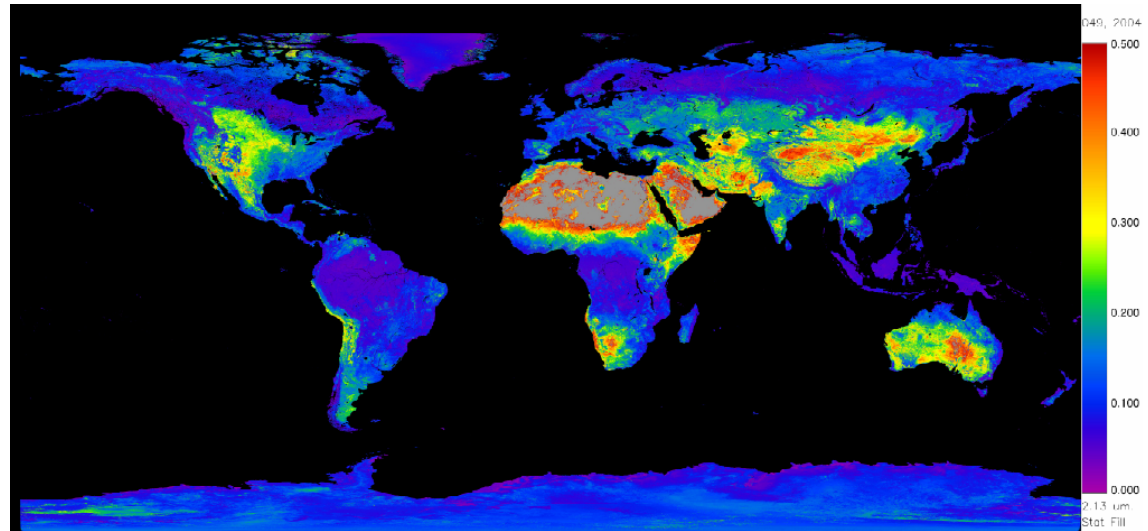
Fig. 2 Global map of the surface albedo at 2130 nm over the continents from observations of the MODIS instrument (white sky albedo for the first half of March 2004; image from http://modis-atmos.gsfc.nasa.gov/ALBEDO/). The good agreement of CO PVCDs for different lower thresholds for CRF (Fig. 4) indicates that the exact choice of the threshold is not